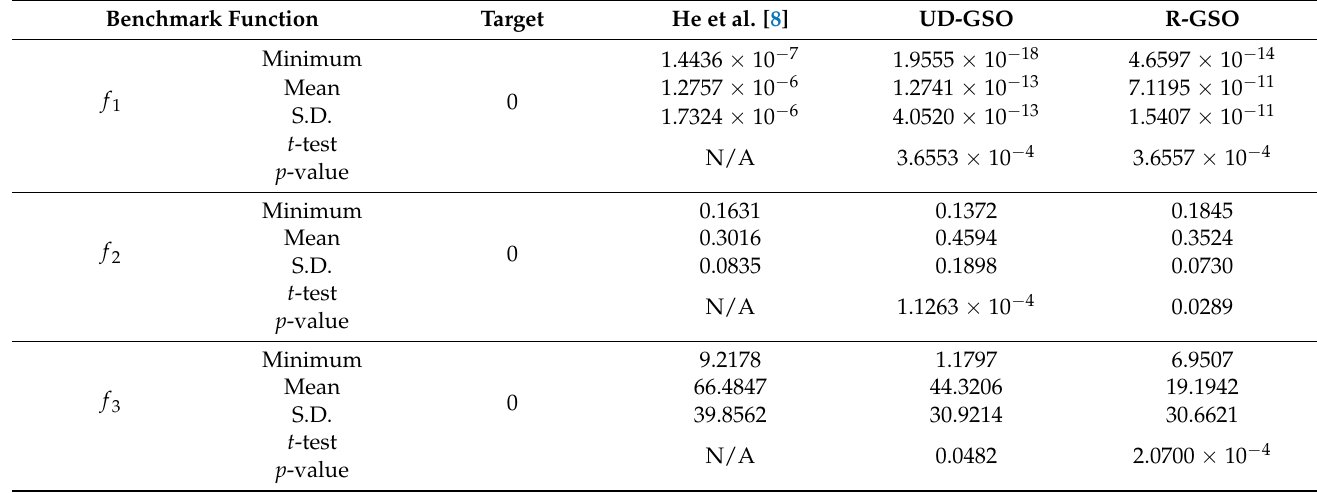
Table 12. Results comparison among GSO [8], UD-GSO, and R-GSO in unimodal functions. Benchmark